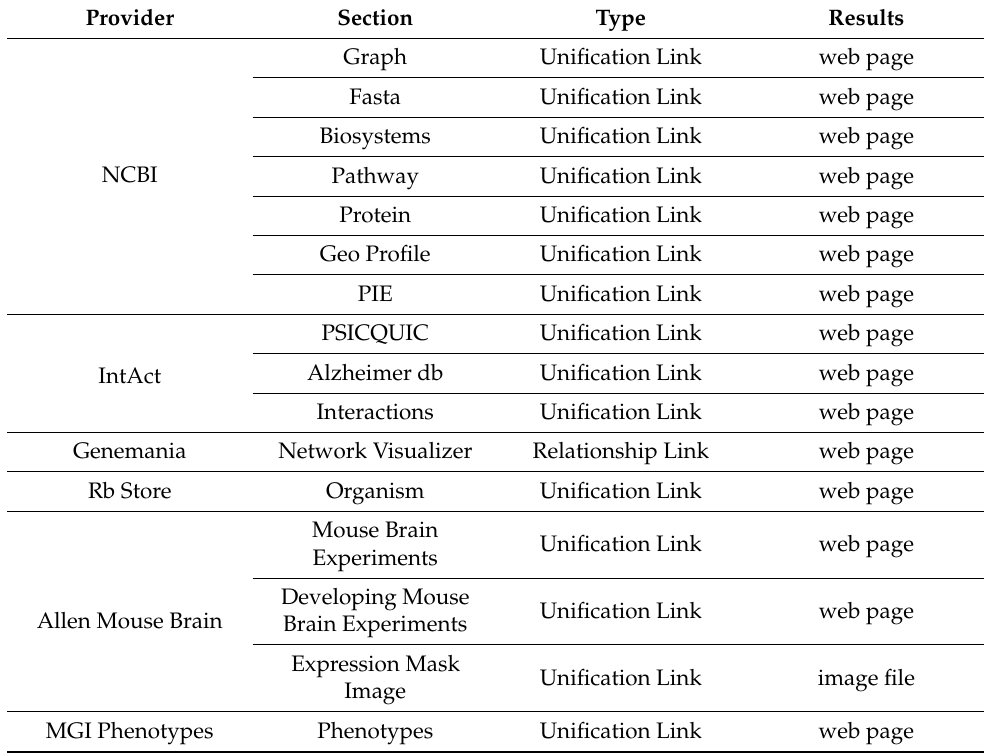
Table 1. Links for each record of BRIDE v2 to tools and